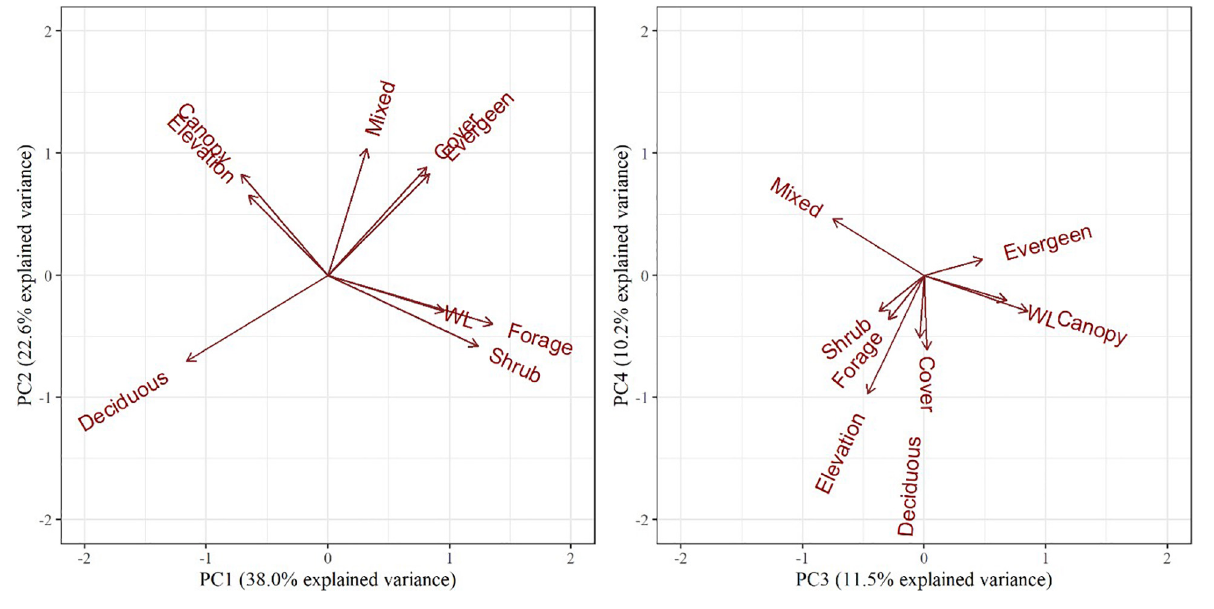
FIGURE 4 | Biplots of the top four principal components for objective 1 examining habitat selection and occupancy. The biplot explains habitat variables selected by female moose ( Alces alces ; n = 74) in northeastern Vermont, United States. The influence of each habitat variable on the components is expressed by the length and direction of the arrows (i.e.,